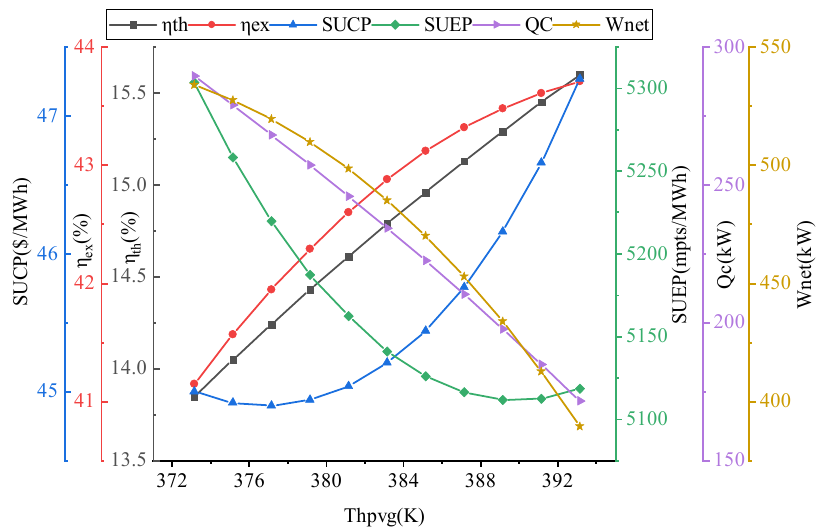
Figure 4. Effect of high pressure evaporation temperature on system performance.